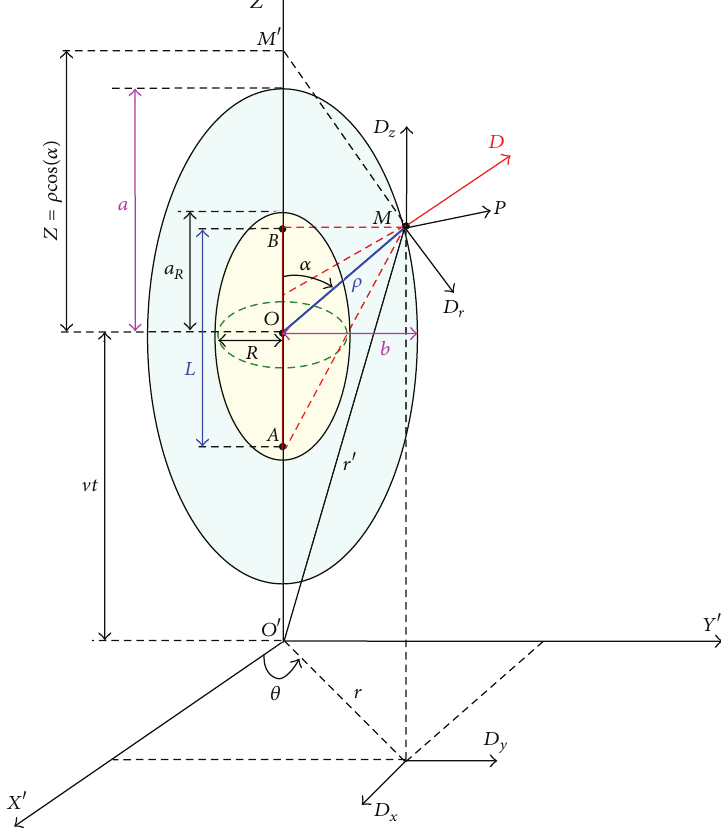
Figure 3: Representation of a moving ellipsoidal polyion, surrounded by its dielectric